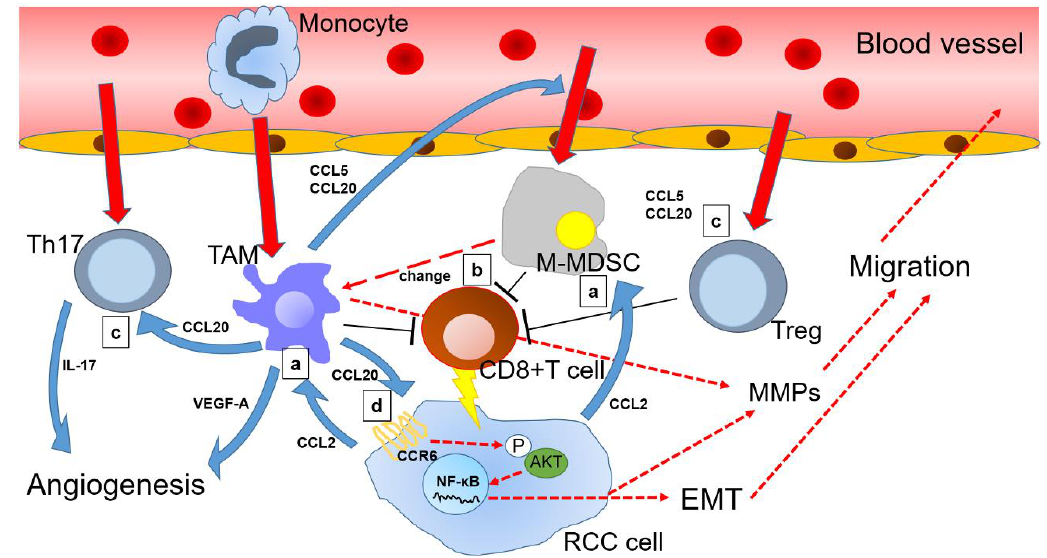
Figure 1. Overview of chemokine (C-C motif) ligand 20 (CCL20) and other related chemokine signals in the renal cell carcinoma microenvironment: ( a ) Renal cell carcinoma (RCC) cells secrete CCL2 to guide tumor-associated macrophage (TAM) and monocytic myeloid-derived suppressor cells (M-MDSC) toward tumor microenvironment (TME); ( b ) M-MDSC suppress CD8 + T cells together with TAM, while a portion of M-MDSC changes into TAM, which continues to reside in the TME; ( c ) TAM mobilizes T helper 17 cells (Th17) and regulatory T cells (Treg) via the CCL20-chemokine receptor 6 (CCR6) axis to enhance angiogenesis and suppress antitumor immunity, thereby indirectly promoting RCC progression; ( d ) Furthermore, CCL20 binds to CCR6 of RCC cells and induces epithelial-mesenchymal transition (EMT) via AKT activation of RCC cells, thereby directly promoting cancer progression. Solid red arrows indicate cell movement. Dotted red arrows indicate changes in cell status. Blue arrows indicate protein secretion. Long T shaped bars indicate functional